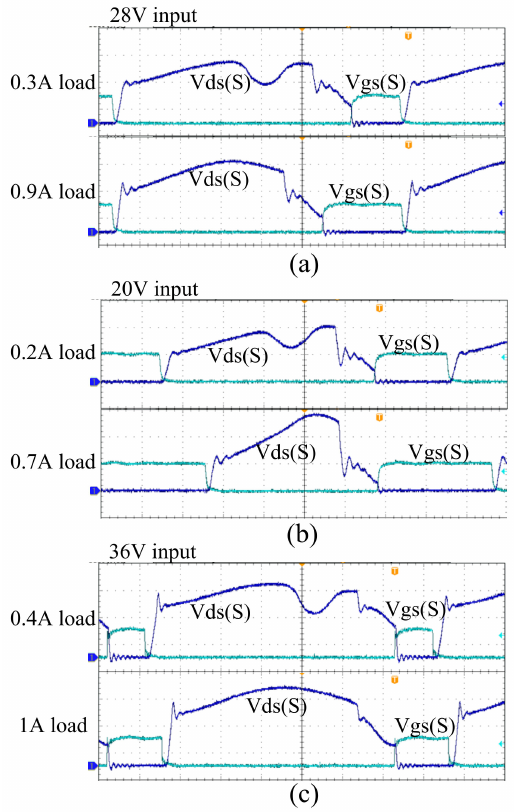
Figure 11. Drain-source voltage and gate-driver voltage of the primary switch at ( a ) 28 V input; ( b ) 20 V input; and ( c ) 36 V input. ( X -axis: 400 ns/div; Y -axis: V ds(S) : 20 V/div; V gs(S) : 10 V/div). The small symbol “T” is the zero position of the time axis.